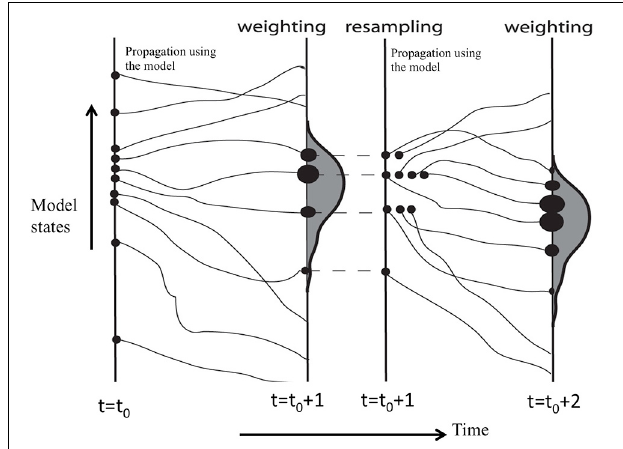
FIGURE 6 | Scheme of the particle filter technique for assimilation of data in a process model (H. Goosse, pers.